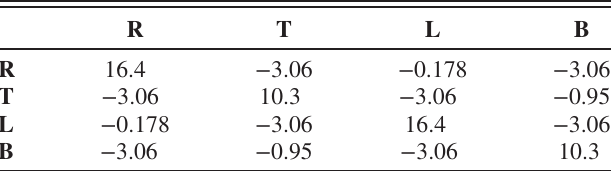
TABLE I. Capacitance matrix of the simulated pickup model; values given in pF.